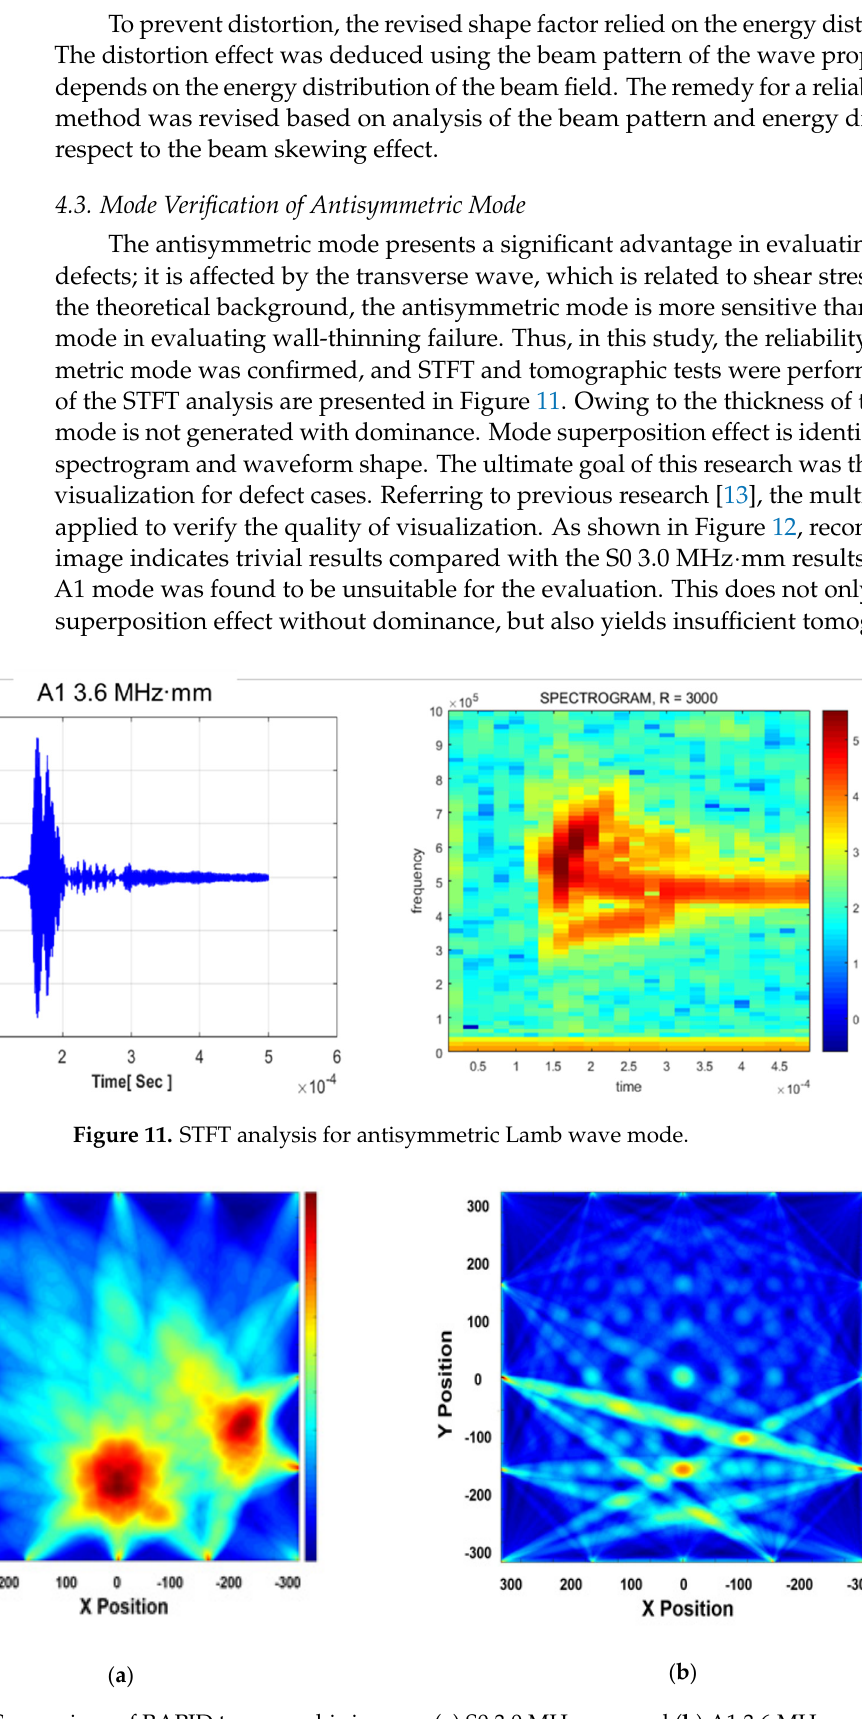
Figure 10. RAPID tomographic images for S0 2.64 to 2.76 MHz·mm: ( a ) S0 2.64 MHz·mm, ( b ) S0 2.70 MHz·mm, and ( c ) S0 2.76 MHz·mm.